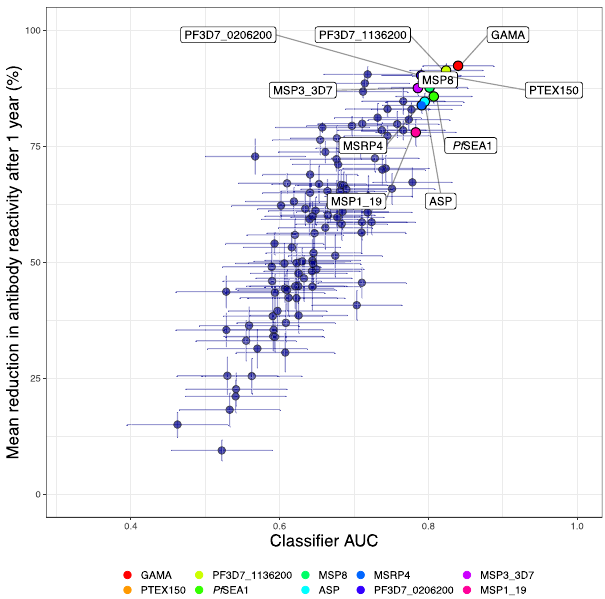
Fig. 7 Relationship between classi fi cation accuracy and the relative reduction in antibody levels. Antibody kinetic model-estimated mean relative reduction in antibody levels after 1 year of follow-up versus classi fi er performance as evaluated using the classi fi er area under the receiver operating characteristic (ROC) curve (AUC). Rainbow colours indicate the antibody responses identi fi ed as top 10 most accurate in detecting recent infection, when using the response to a single antigen. Vertical and horizontal error bars represent the 95% con fi dence interval (CI) of the estimated mean relative reduction in antibody levels and classi fi er AUCs, respectively. Classi fi ers were fi tted to data on antibody responses measured in 282 samples from 107 unique study participants and controls. Antibody kinetic models were fi tted to antibody data measured in 240 samples from 65 unique study